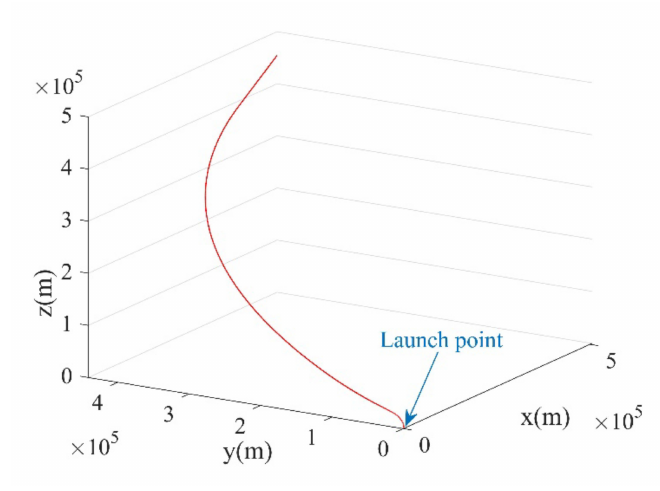
Figure 5. Simulation diagram of aerospace vehicle